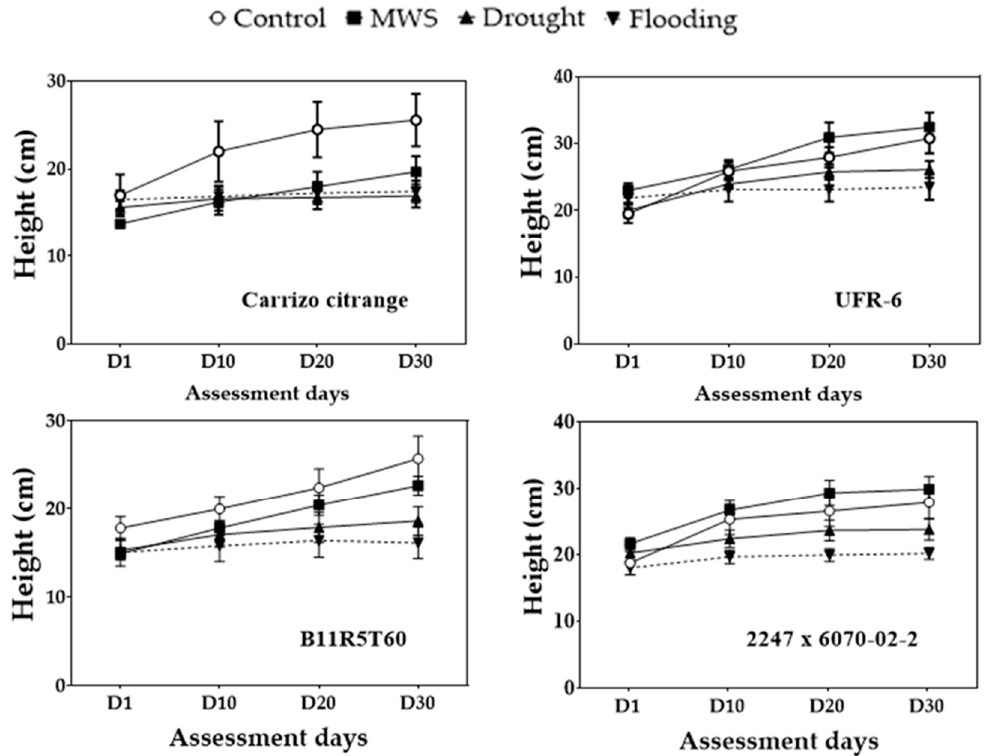
Figure 2. Time course for the mean height (cm) values ± standard error (SE) under four water treatments (Control, MWS, Drought, and Flooding) on four citrus rootstocks (Carrizo citrange, UFR-6, B11R5T60, and 2247 x 6070-02-2) over 11 weeks of evaluation. MWS: Medium Water Stress.